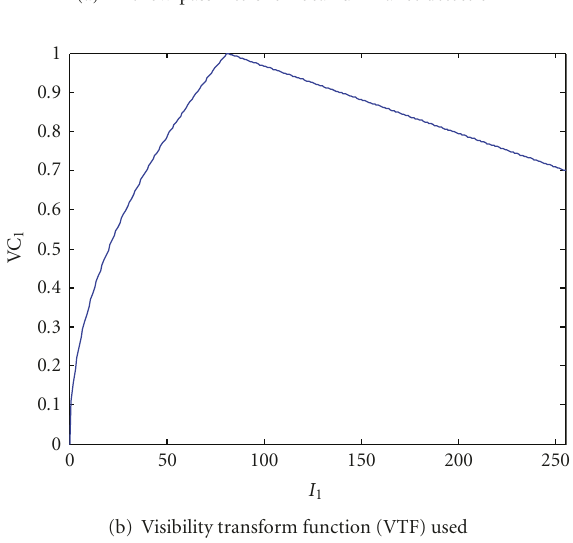
Figure 8: Implementation of the luminance